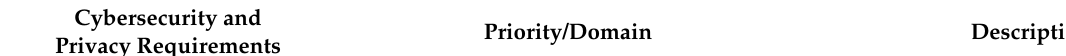
Table 6. List of contemplated assessable cybersecurity and privacy